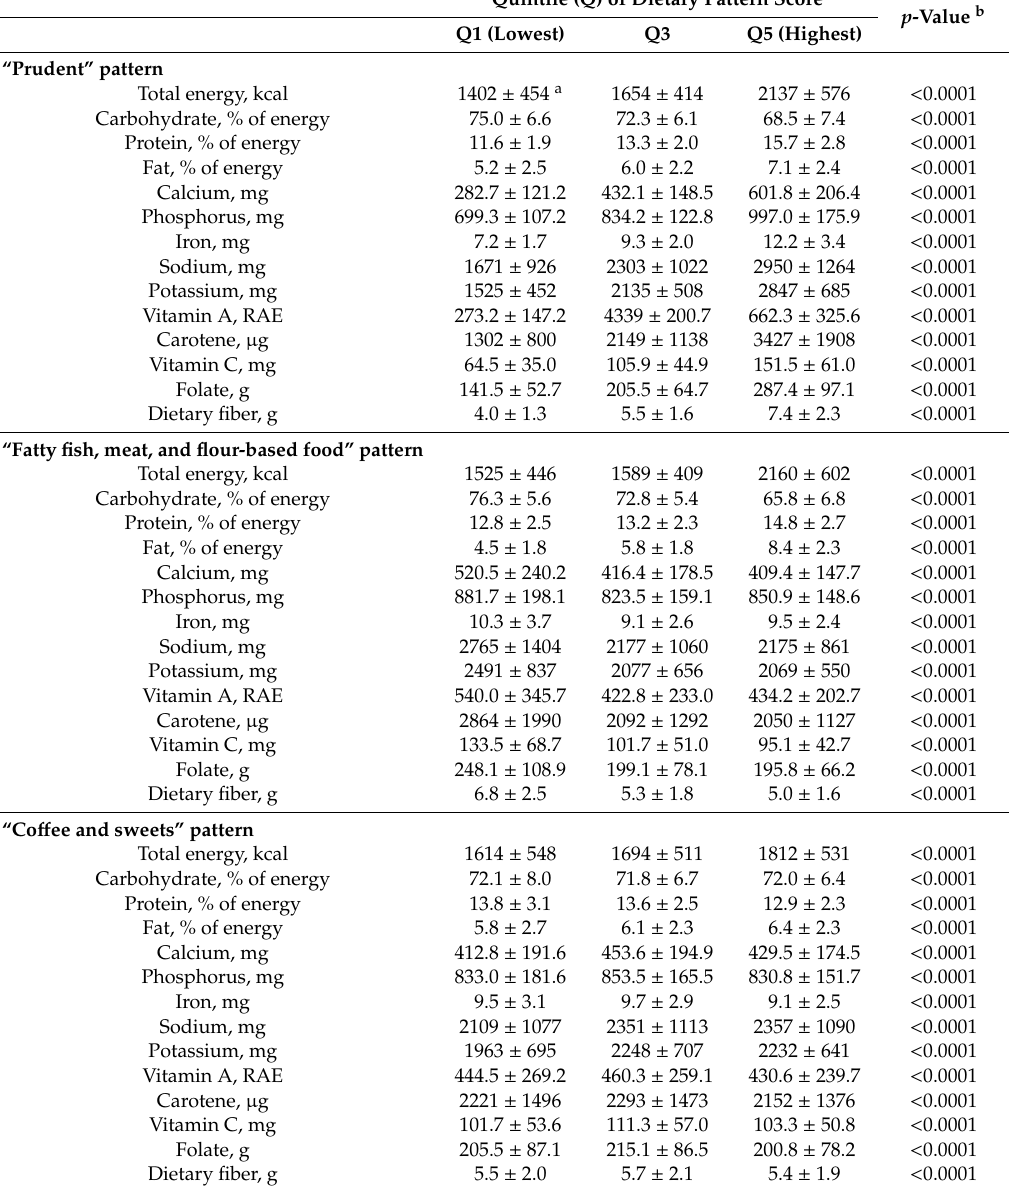
Table 5. Energy and nutrient intake at baseline across quintiles of each dietary pattern score in the middle-aged Korean women, the KoGES-HEXA